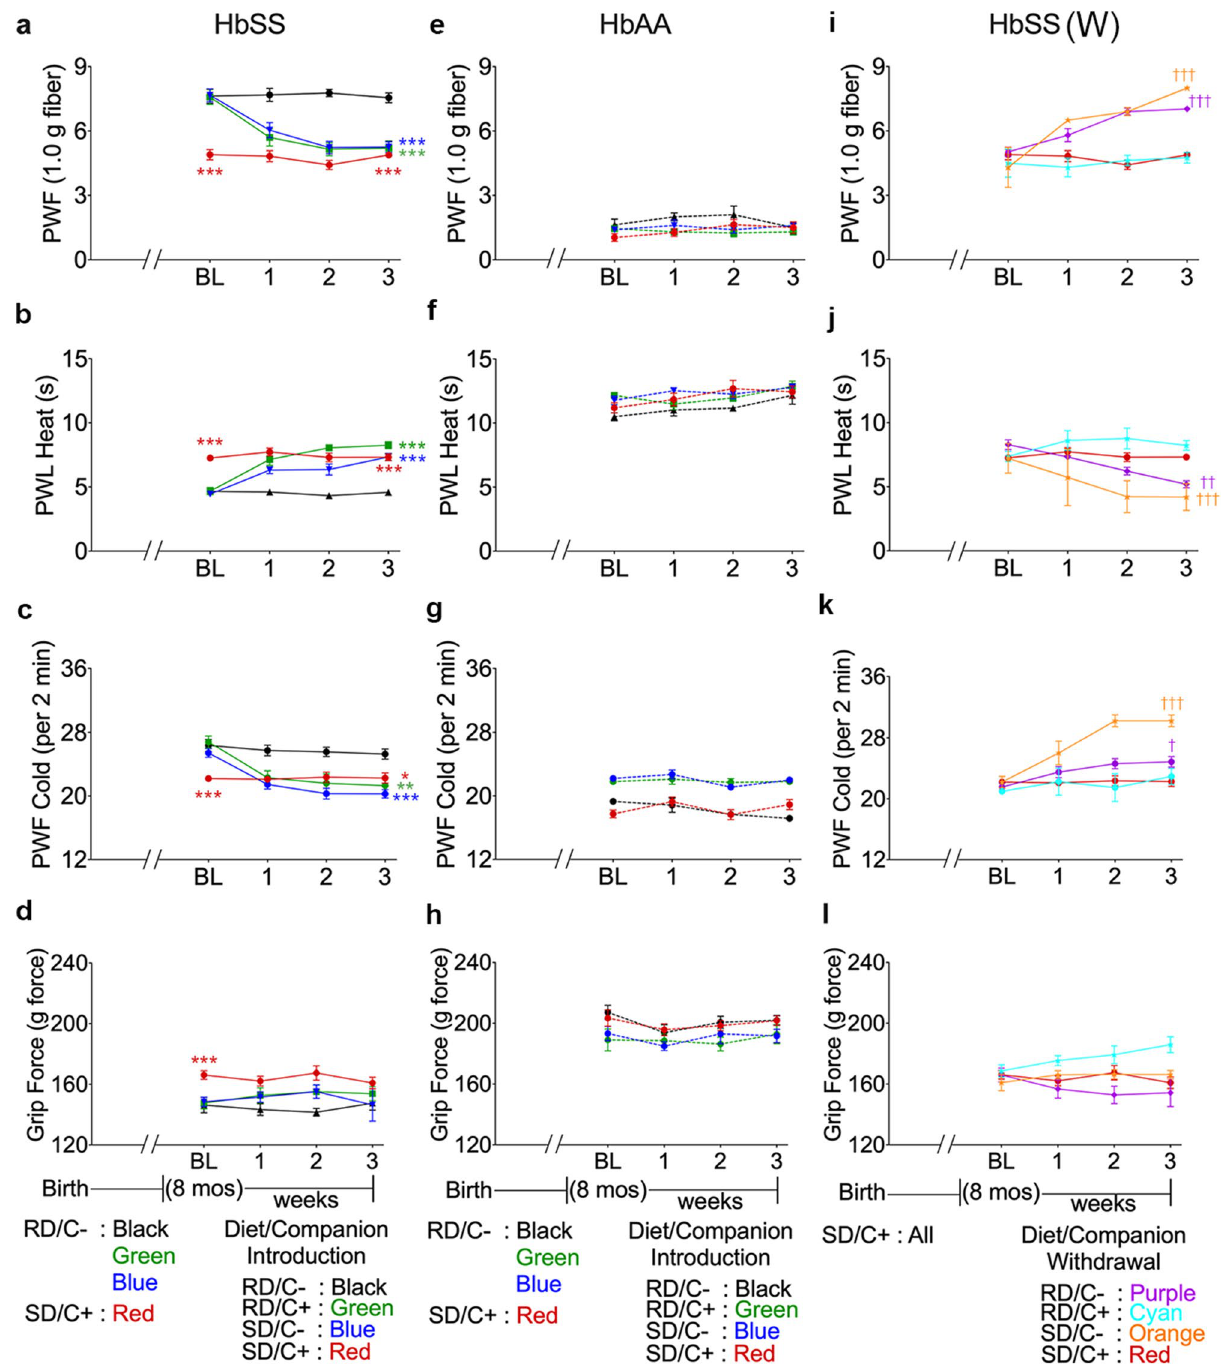
Figure 1. Effect of enriched diet and companionship on hyperalgesia in male sickle and control mice. Mice were fed specific diets from birth until approximately 8 months of age as indicated on the left side of each figure. Diet and/or companion introduction or withdrawal was done for three weeks following baseline testing; specific treatment groups are listed on the right side of the figure. Hyperalgesia measures for all mice are shown for, mechanical hyperalgesia as PWF in response to 1.0 g von Frey filaments; heat hyperalgesia as PWL in response to a heat stimulus; cold hyperalgesia as PWF per 2 min on a cold plate at 4 °C and deep tissue/ musculoskeletal hyperalgesia as grip force exerted by forelimbs. ( a – d ) Male sickle mice (HbSS) given sickle or regular diet in the presence or absence of a female companion. ( e – h ) Male control mice (HbAA) given sickle or regular diet in the presence or absence of a female companion. ( i – l ) Male sickle mice (HbSS W) fed sickle diet in the presence of a female companion followed by withdrawal of sickle diet replaced with regular diet and/or withdrawal of the female companion. Regular diet without companionship, RD/C−, nSS = 12, nAA = 8; regular diet with companionship, RD/C+, nSS = 10, nAA = 10; sickle diet without companionship, SD/C−, nSS = 13, nAA = 10; sickle diet with companionship, SD/C+, nSS = 20, nAA = 11; withdrawn from sickle diet, W RD/C+, nSS = 5; withdrawn from companionship, W SD/C−, nSS = 6; withdrawn from sickle diet and companionship, W RD/C−, nSS = 20, nAA = 8; mixed linear models with Tukey’s post-hoc test, * p < 0.05, ** p < 0.01, *** p < 0.001 compared to HbSS RD/C−; † p < 0.05, †† p < 0.01, ††† p < 0.001 compared to HbSS SD/C+. PWF, paw withdrawal frequency; PWL, paw withdrawal